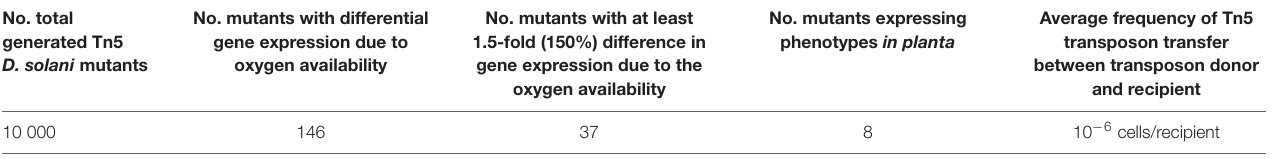
TABLE 1 | Workflow of the selection of oxygen-dependent Dickeya solani IPO2222 Tn5 mutants (details provided in the text). No. total generated